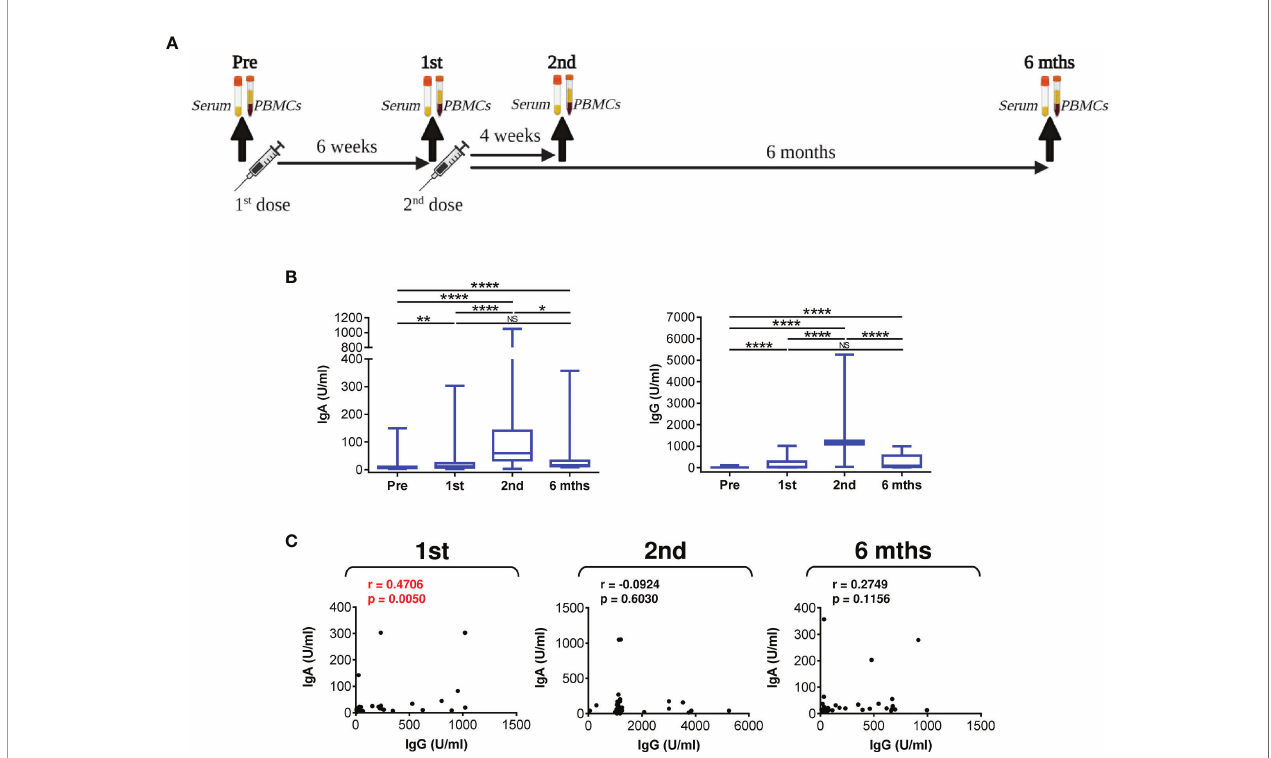
FIGURE 1 | The serum levels of anti-RBD IgA and IgG antibodies during and after vaccination. (A) The sample collection strategy. (B) Serum levels (U/ml) of anti-RBD IgA ( left panel ) and IgG ( right panel ) antibodies before the fi rst (Pre) and second (1st) vaccine doses were administered and 4 weeks (2nd) and 6 months (6 mths) after the second vaccine dose was administered. (C) Correlations between the serum levels (U/ml) of anti-RBD IgA and IgG antibodies determined in (B) In B, box and whisker plots (2.5 – 97.5 percentile) are shown, and the signi fi cance of differences among the groups (Pre, 1st, 2nd, and 6 mths) is indicated (NSp>0.05, * p <0.05, ** p <0.01, **** p <0.0001; n = 34; matched-pair one-way ANOVA with Dunn ’ s posttest). In C, Spearman ’ s rank-order correlation coef fi cient (r) and the signi fi cance ( p value; n = 34) are